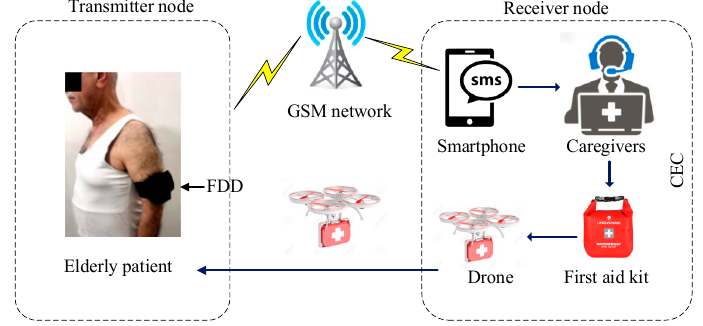
Figure 1. Block diagram of the overall AFAS.